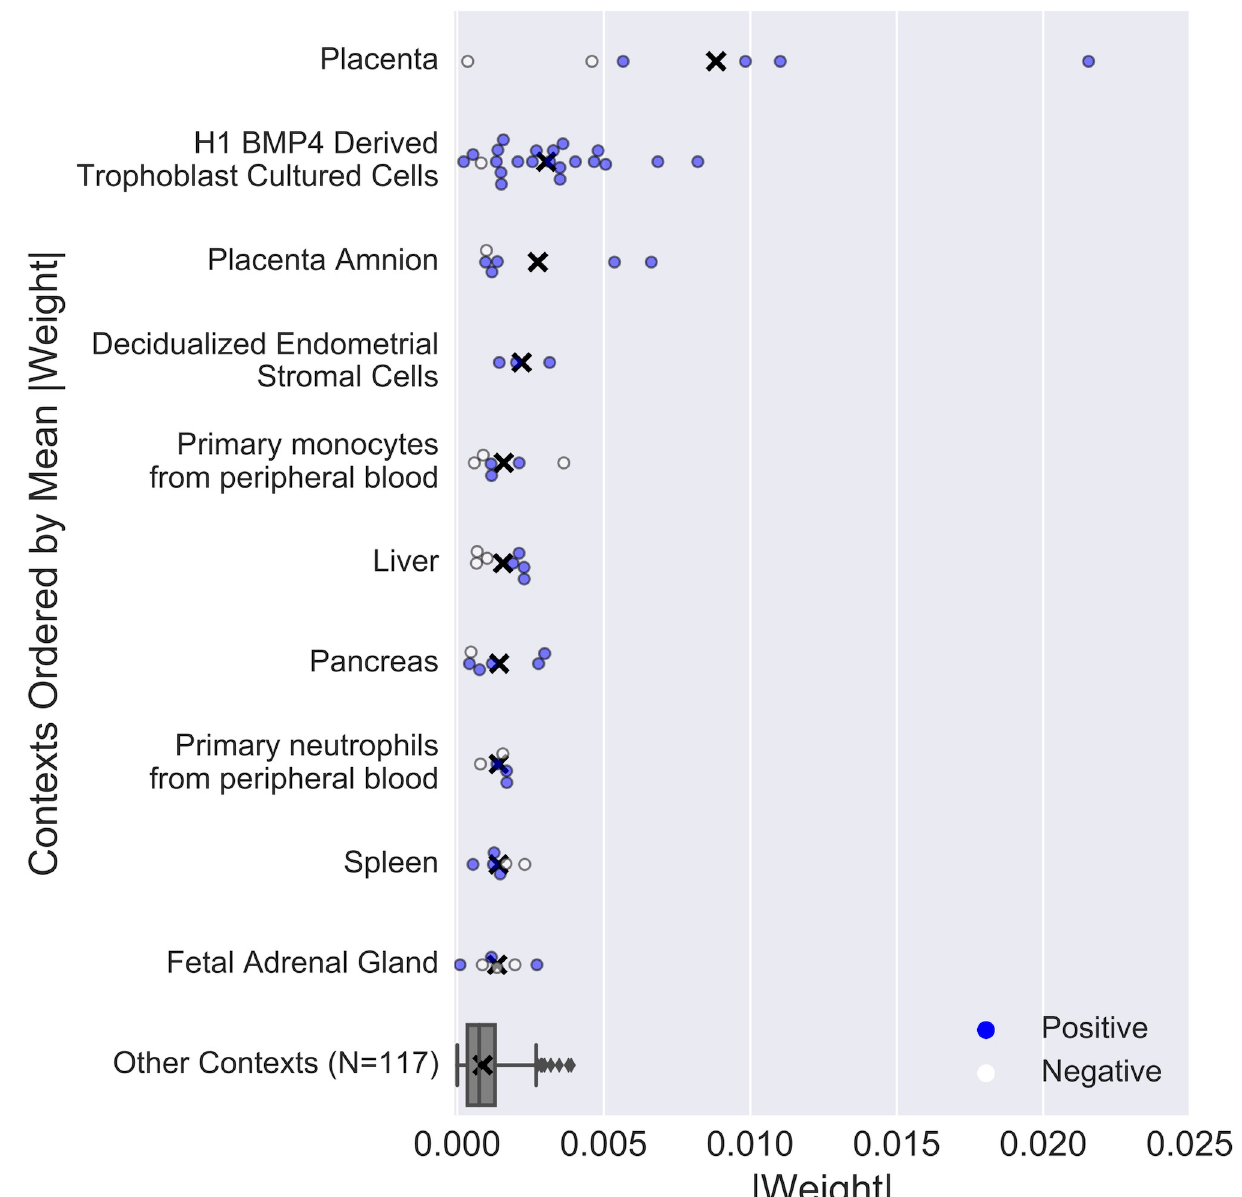
Fig 3. Functional genomics data from pregnancy-related tissues are highly weighted by the placental enhancer classifier. The absolute value of the weight assigned to each functional genomics feature in the SVM is plotted (positive weight: blue, negative weight: white, mean of absolute weights: black X). The absolute weights on the functional genomics features from the other 117 contexts were collapsed into one box plot (outliers are plotted as gray